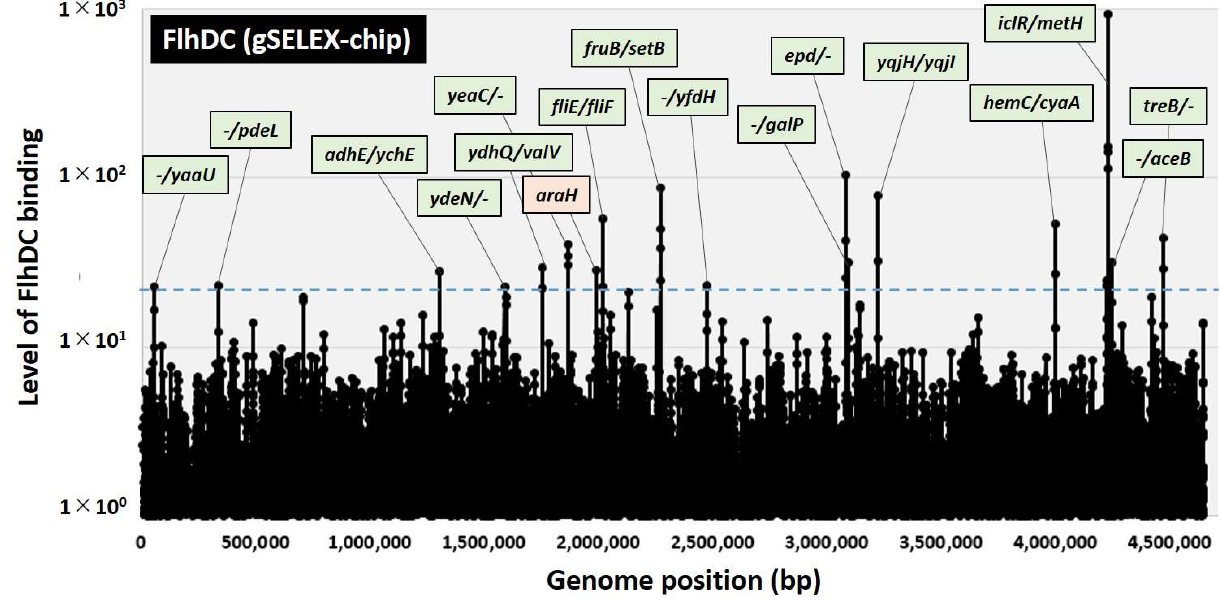
Figure 1. Identification of FlhDC-binding sites in the E. coli K-12 genome using gSELEX-chip. gSELEX screening of DNA-binding sequences was performed for FlhDC, a flagella master regulator TF of E. coli , using purified His-tagged FlhDC and a library of DNA segments from the E. coli K-12 W3110 genome. Following gSELEX, a collection of DNA fragments was subjected to gSELEX-chip analysis using the tiling array of the E. coli K-12 genome. The blue dotted line represents the cutoff level of twenty, and Table 1 lists the FlhDC-binding sites from cutoff level ten. Peaks shown in green represent the FlhDC-binding sites inside spacer regions, whereas peaks shown in orange represent the FlhDC-binding sites inside ORFs.